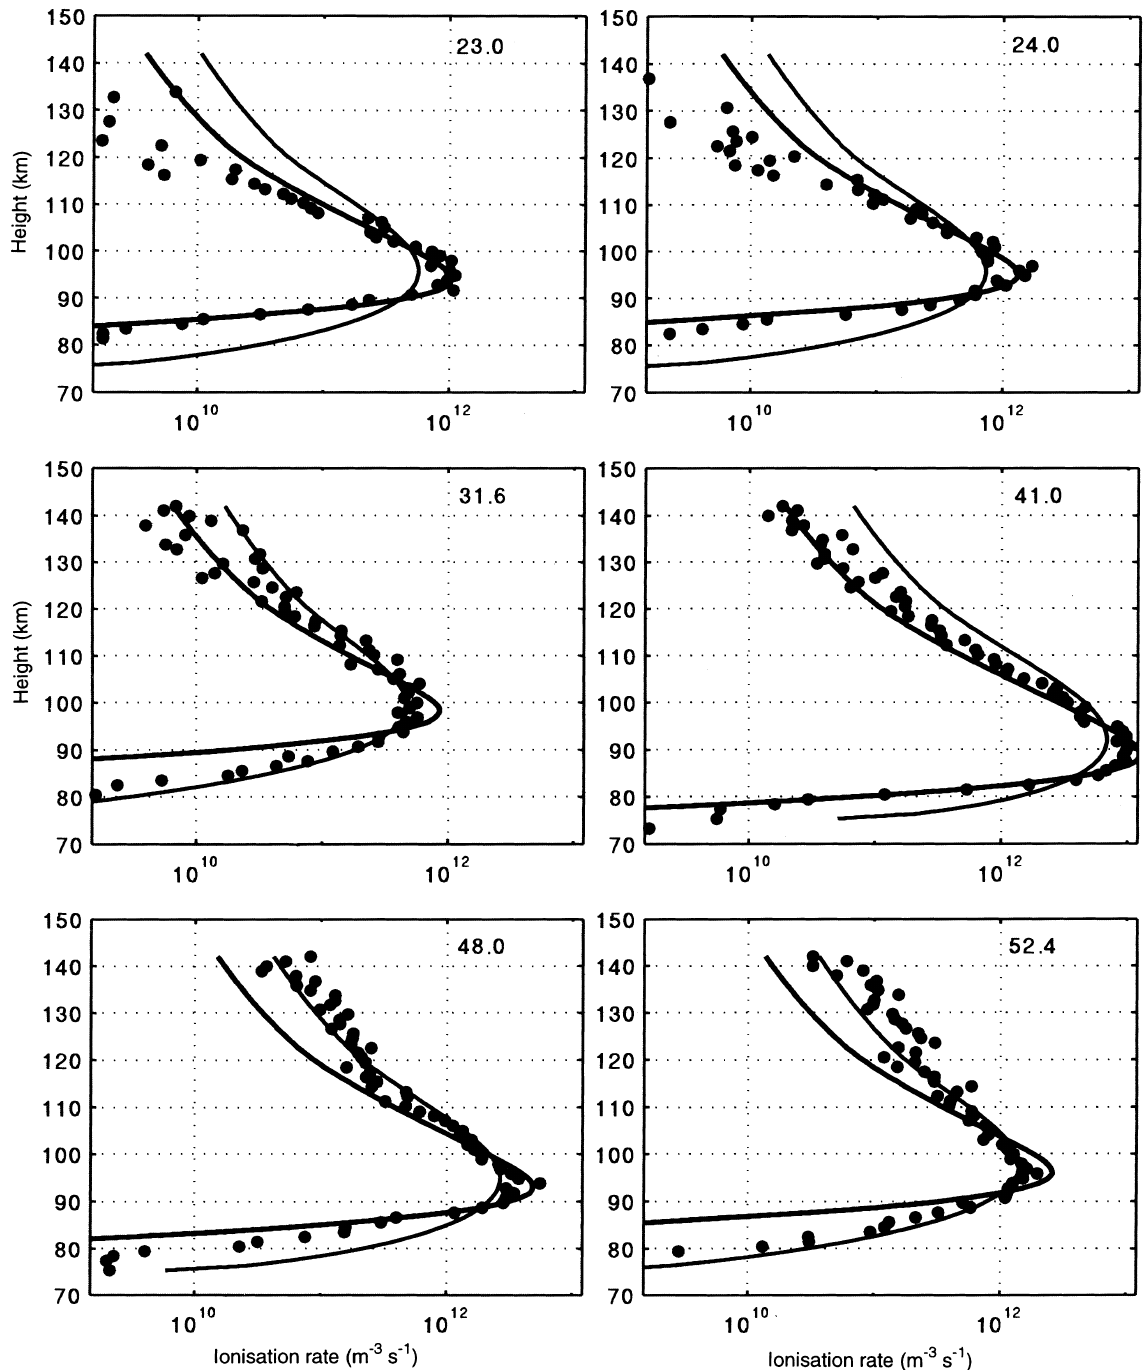
Fig. 6. Selected ionisation rate profiles from the first passage of the arc system. Black dots are from measurements at 0.2-s resolution. The thick line is a best fit to a monoenergetic input flux. The thin line is a